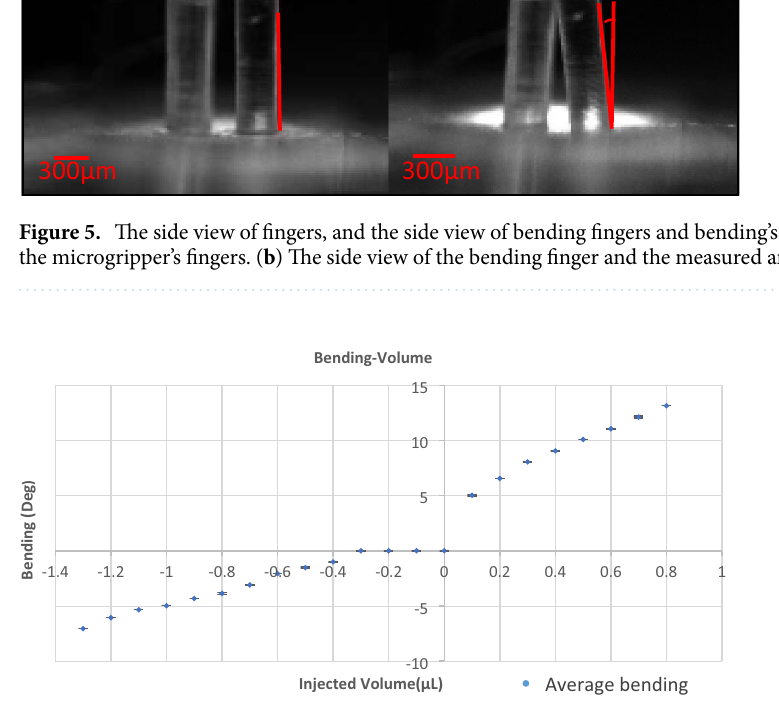
Figure 6. The microgripper bending characterization. The bending of the finger was measured under an optical microscope. The angle (α) was measured as a function of the injected volume of water in the cavity. The negative angles are representing the angles during the closing